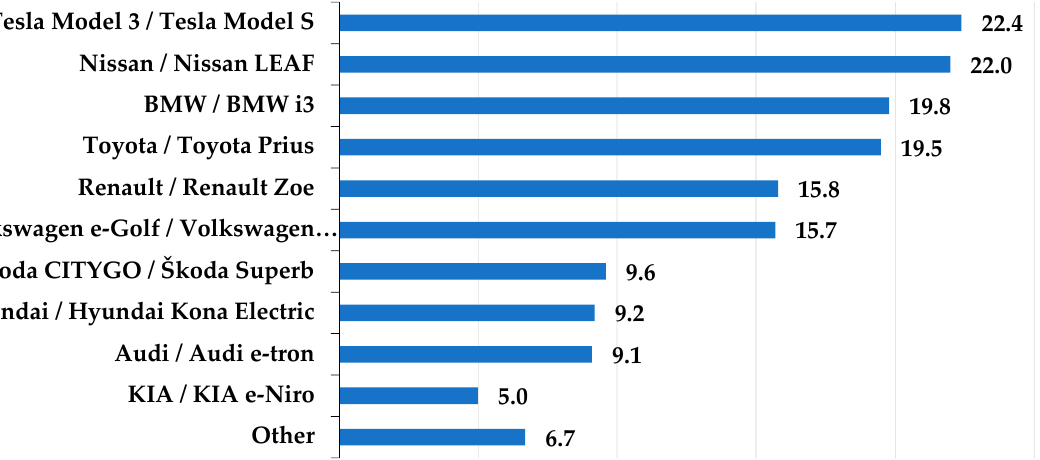
Figure 2. Survey responses of e-vehicles (%). Source: Authors’ research based on [19,44]. Polish e-vehicle FSE 01, presented to the general public, uses lithium-ion 14 kWh batteries, which allow for covering the distance of 102 km. The cost of covering the distance of 100 km can range from 6 PLN to 7 PLN (in the case of G12 night tariff), and up to as much as 21 PLN (in the case of public chargers). Charging based on single phase chargers will take approx. 6 h, and half of that time for three phase chargers. The expected price of the car is 100 thousand PLN. Both technical parameters (range) and the price indicate that